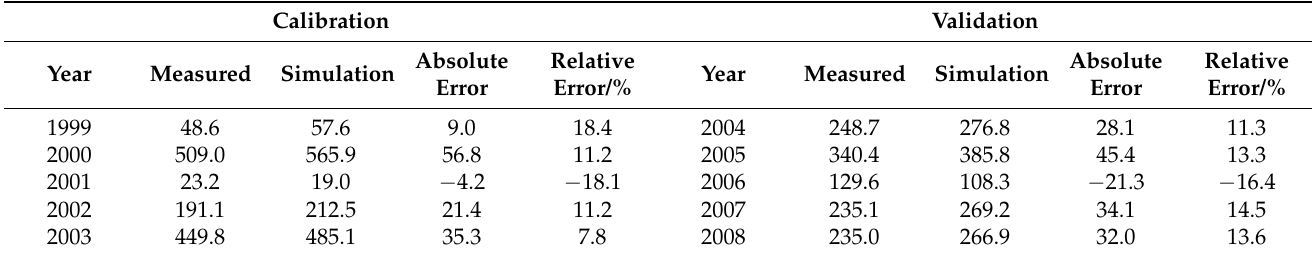
Table 2. Comparison of annual sediment transport rate at Lutaizi station (unit: 10,000 t/year). Calibration